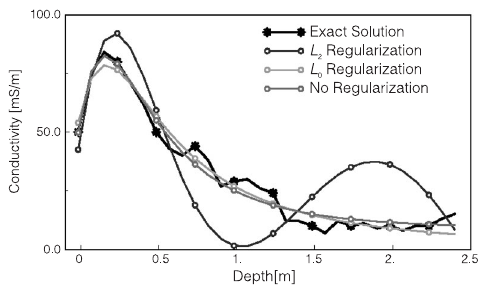
Fig. 7. Inverse problem solutions for the input data in fig. 4b. Inversions with no regularization and with L regularization gives a meaningful with L 2